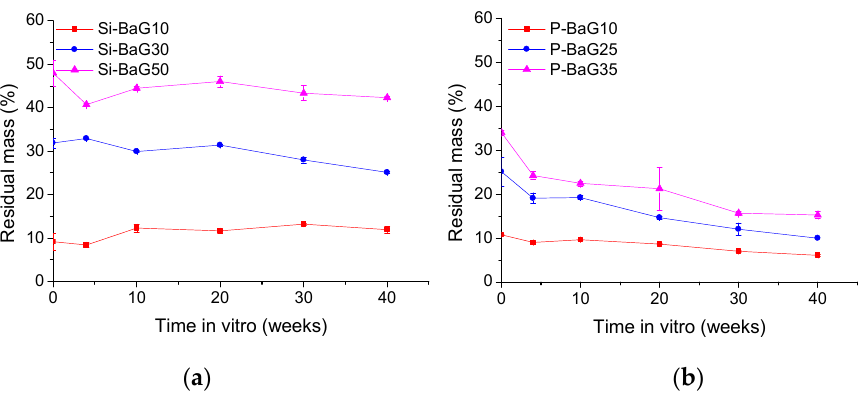
Figure 7. Changes in the BaG content in ( a ) Si-BaG and ( b ) P-BaG composites during the immersion of 40 weeks in Tris.